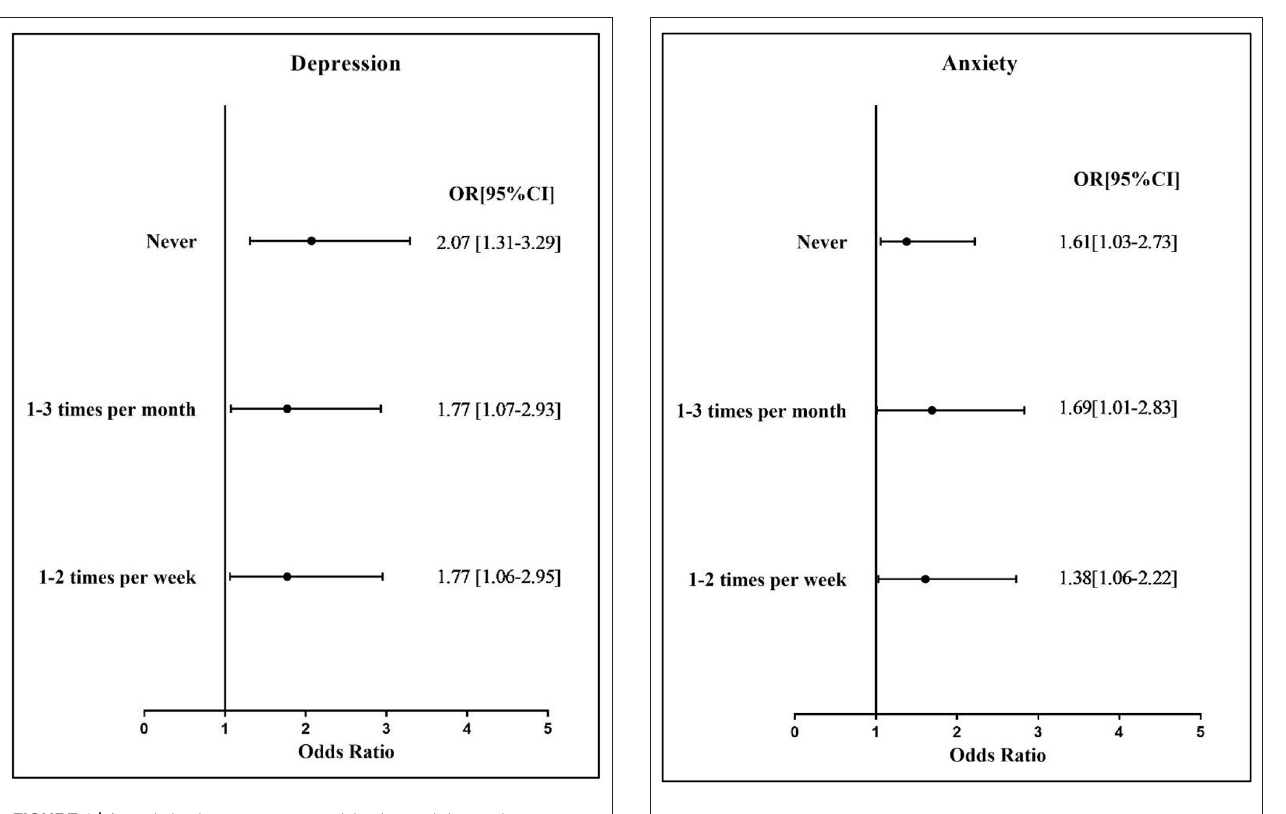
FIGURE 2 | Association between sport participation and anxiety disorder severity. OR, odds ratio; CI, confidence interval. Reference group: 3 or more times per